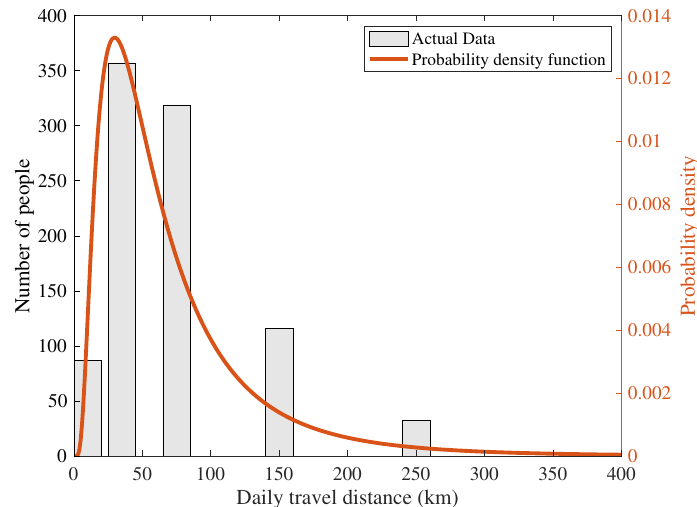
Figure 3. Travel Distance Data and Probability Density Function.